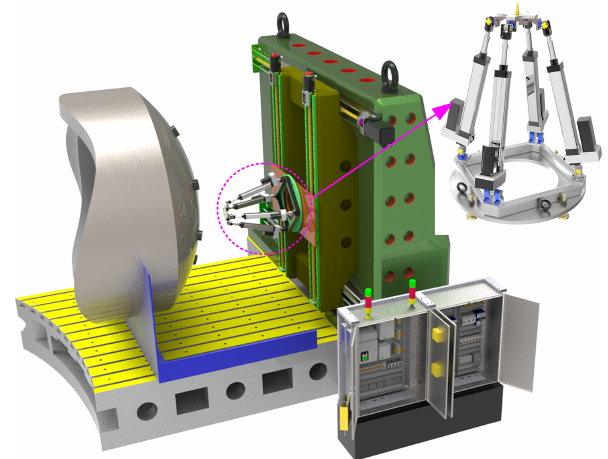
Figure 1. The five-axis linkage processing equipment.